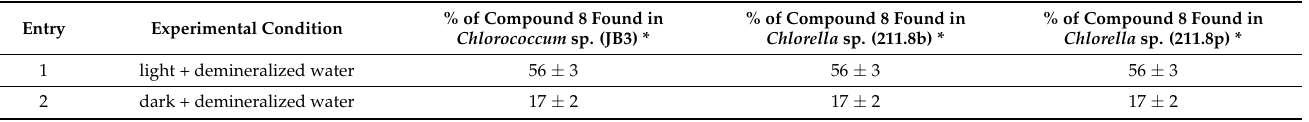
Table 2. Oxidation of valencene (3 g/L) in the different experimental conditions. All the value reported in the table are derived from the mathematical average of the different samples related to each other. * The percentage of compound 8 is calculated, integrating the peaks of the chromatogram of the crude